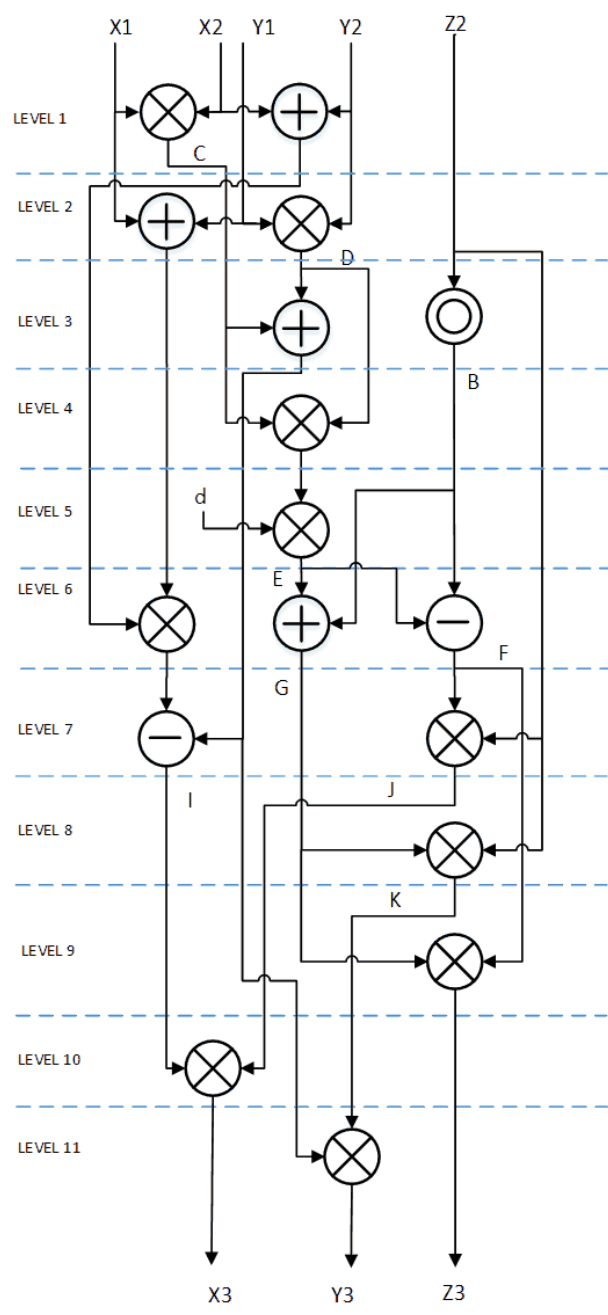
Figure 2. ED25519 Point addition flow